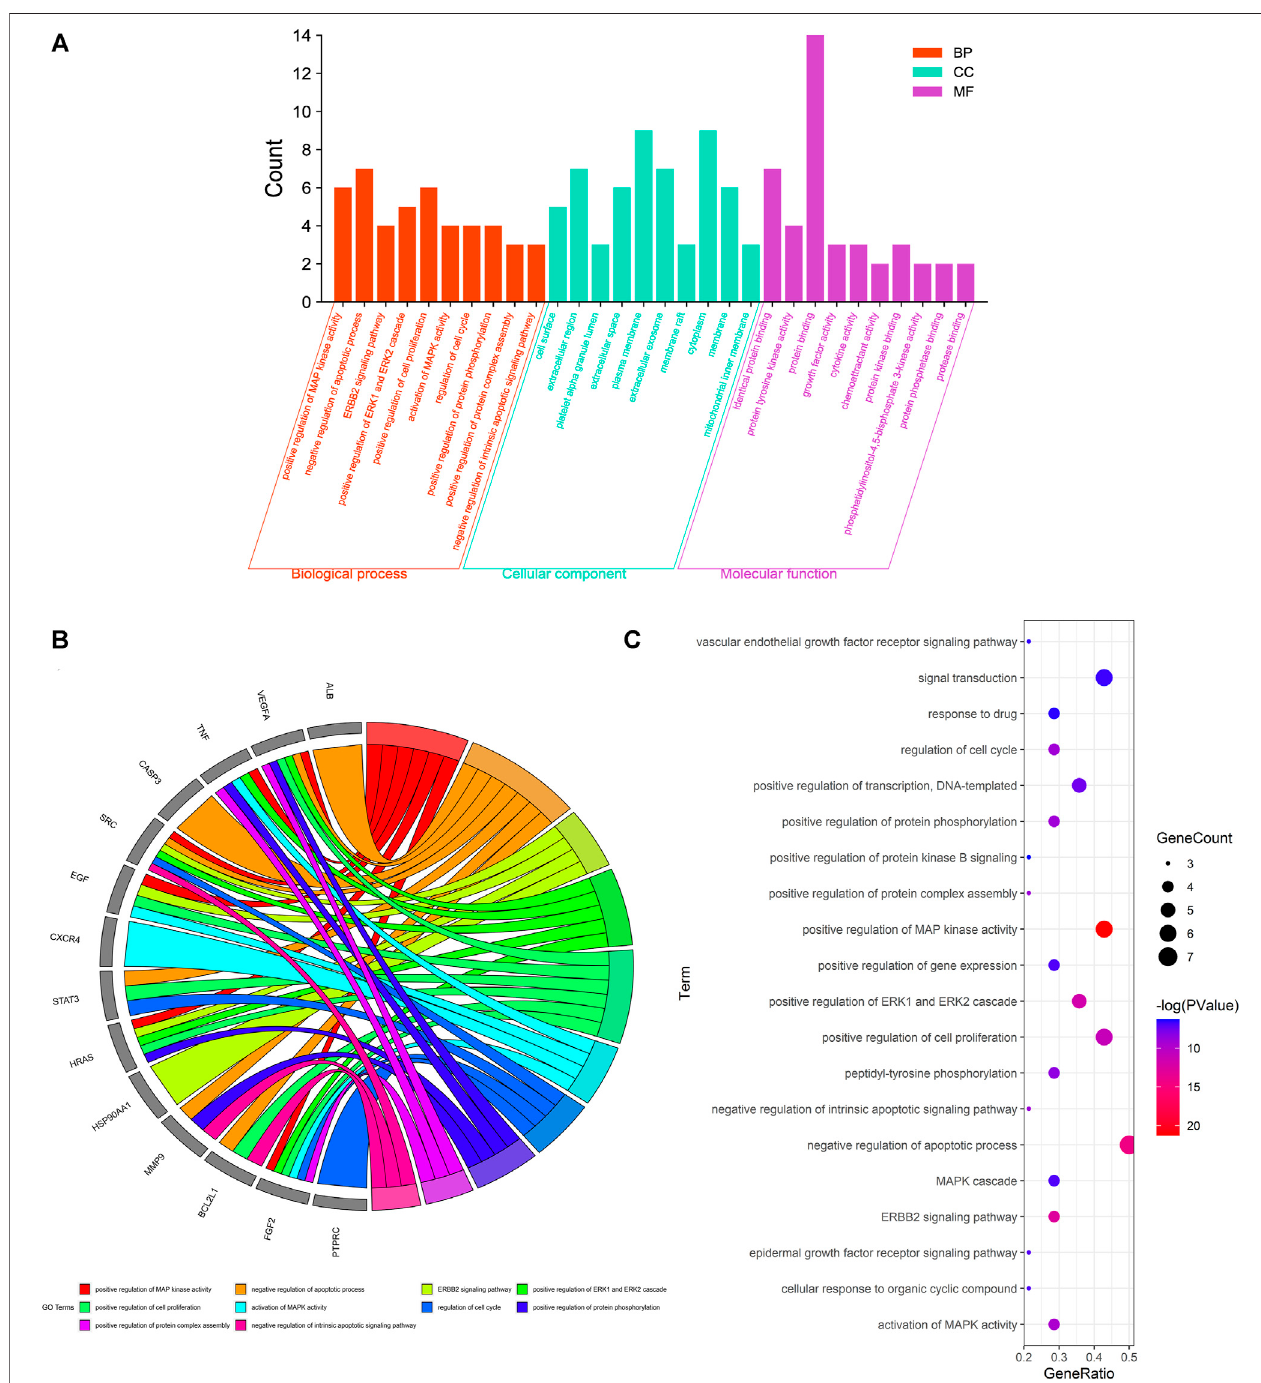
FIGURE 3 | GO-based enrichment analysis for disclosing the top 20 biological processes of Pachyman in treating HCC, as shown in bar chart (A) , circle diagram (B) , bubble graph (C) .